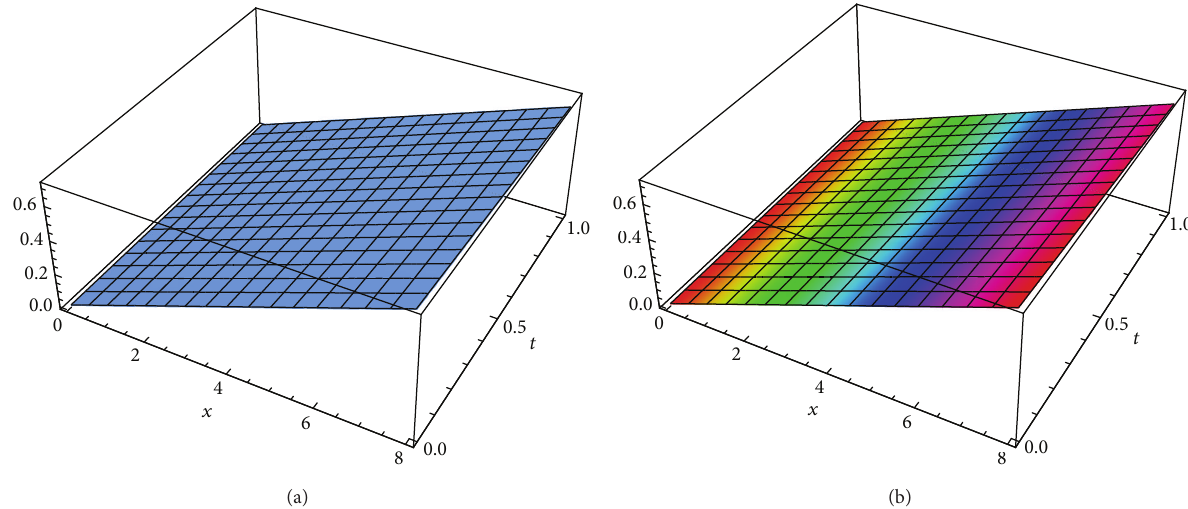
Figure 9: Three-dimensional plot for the solution of Saint Venant equations via homotopy perturbation method obtained (a) V (𝑥, 𝑡) = V 0 + V V V V V V V (𝑥,𝑡) = V V 1 + 2 + 3 + 4 + 5 + 6 + 7 (b)